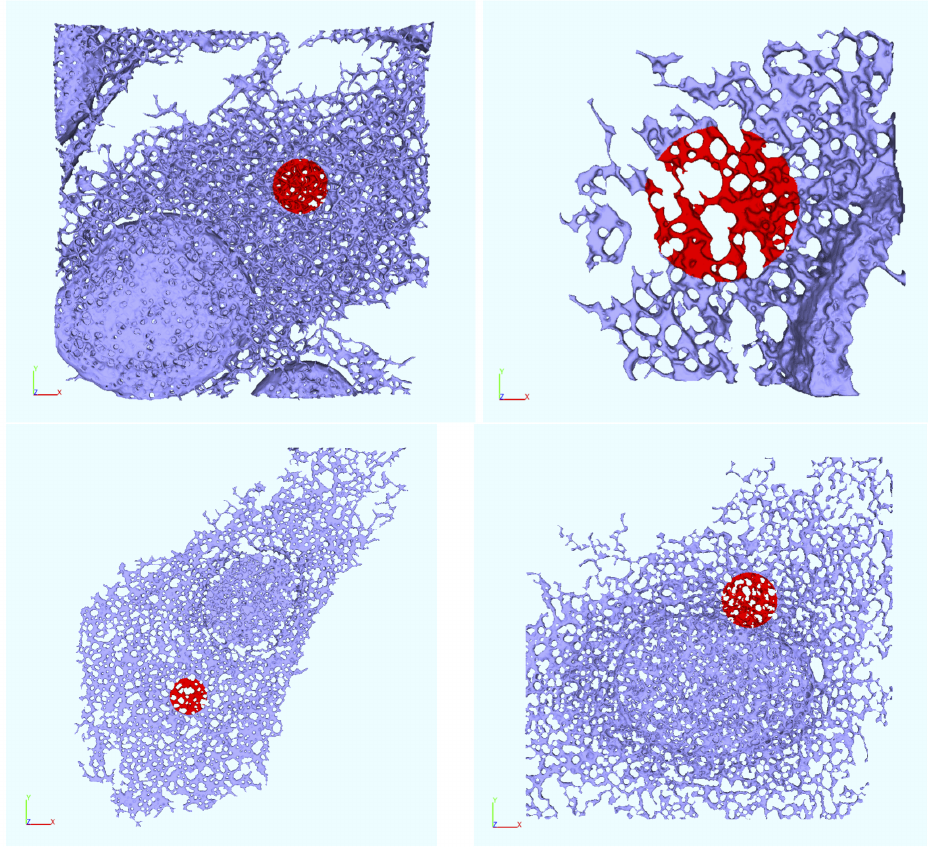
Figure A1. The reconstructed ER geometries E i , i = 2,3,4,5 and exemplar FRAP regions. FRAP ROIs indicated in red, covering a surface of about 38 µ m 2 enabling the reader to estimate the total size of the